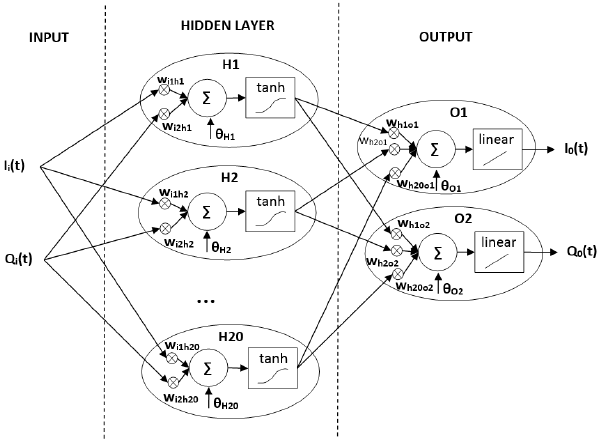
Figure 9. Digital predistorter (DPD) technique using a neural network.